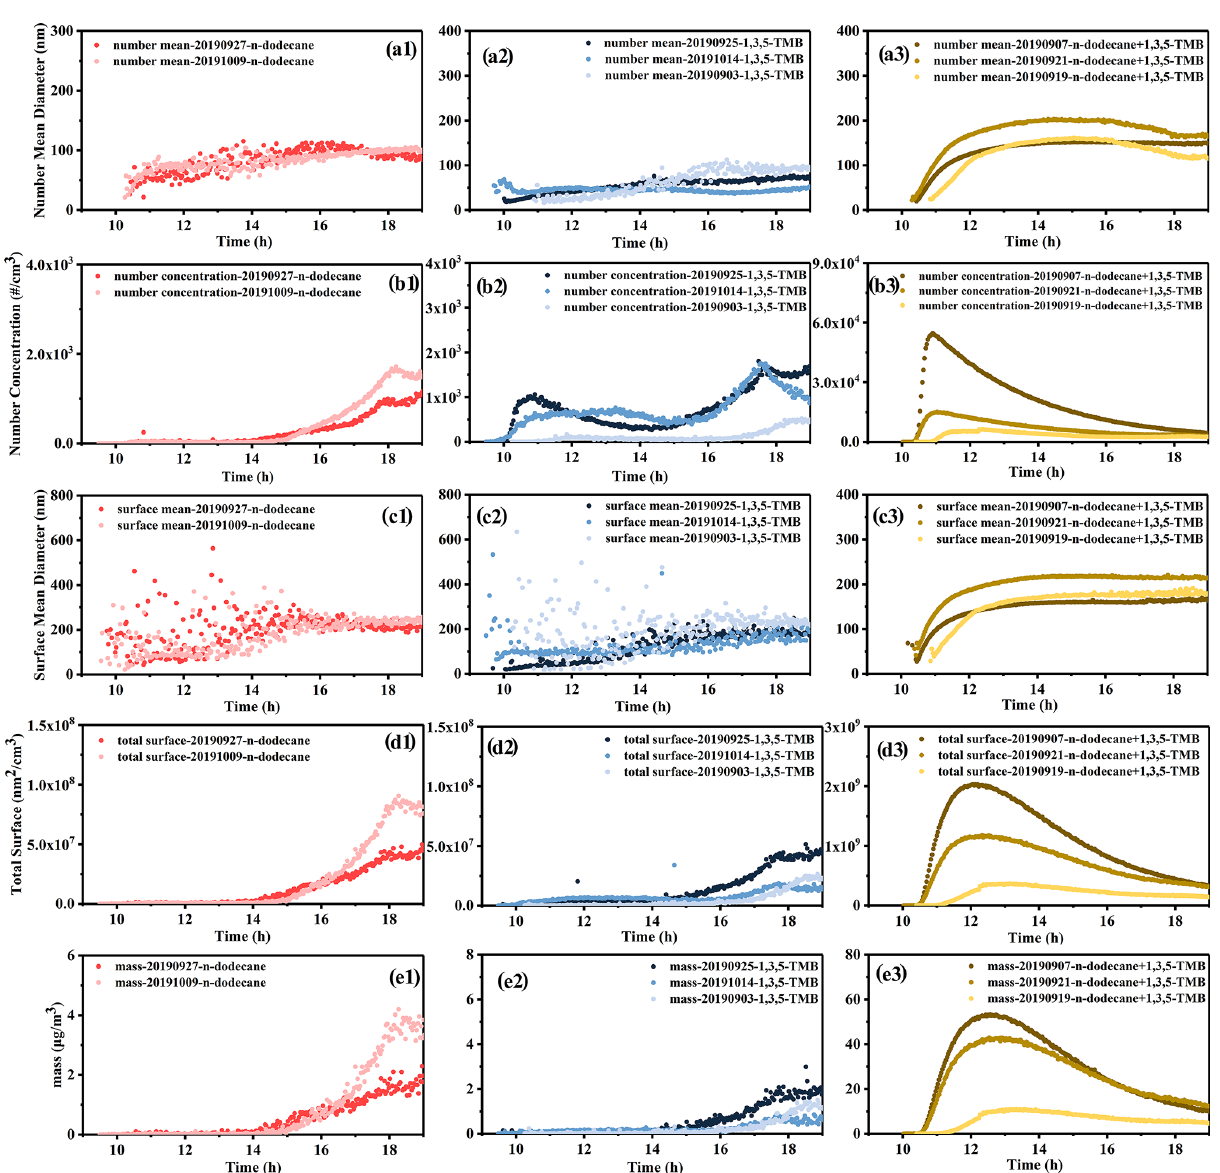
Figure 8. The formation and evolution of particles during the photochemical reactions in summer. The number mean diameter of particles derived from n -dodecane (a1) , 1,3,5-TMB (a2) , mixed AVOCs (a3) ; the number concentration of particles derived from n -dodecane (b1)